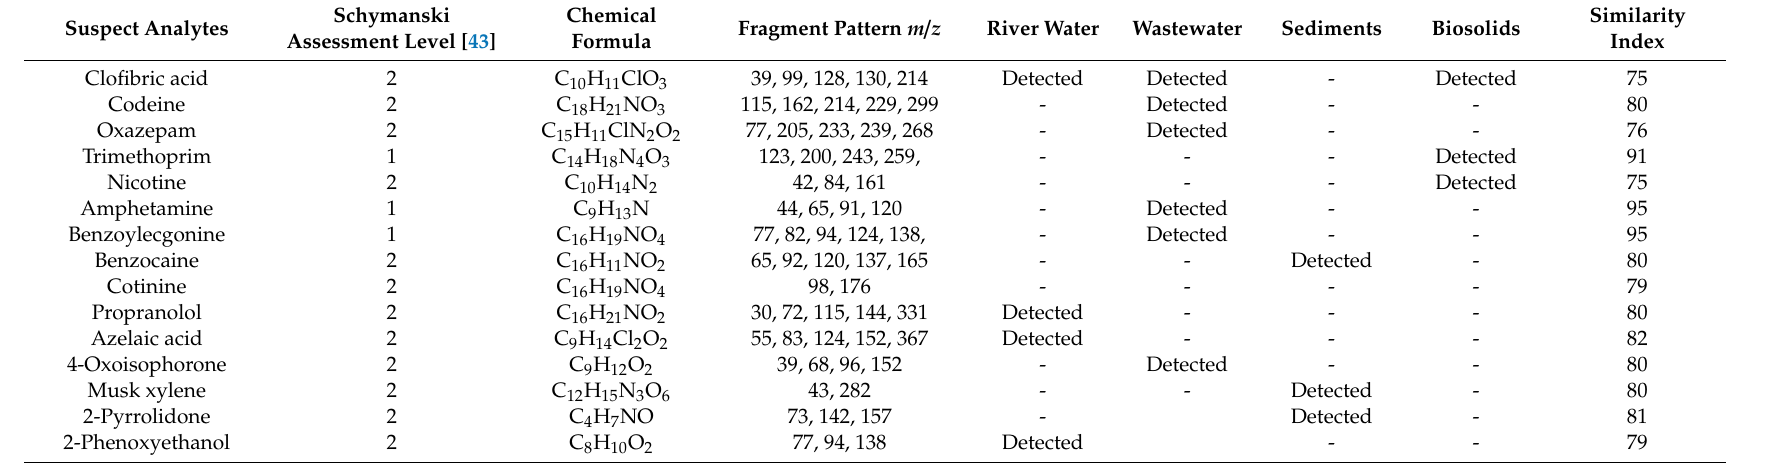
Table 6. Suspect analysis of pharmaceutical and personal care products in the Msunduzi and Mgeni